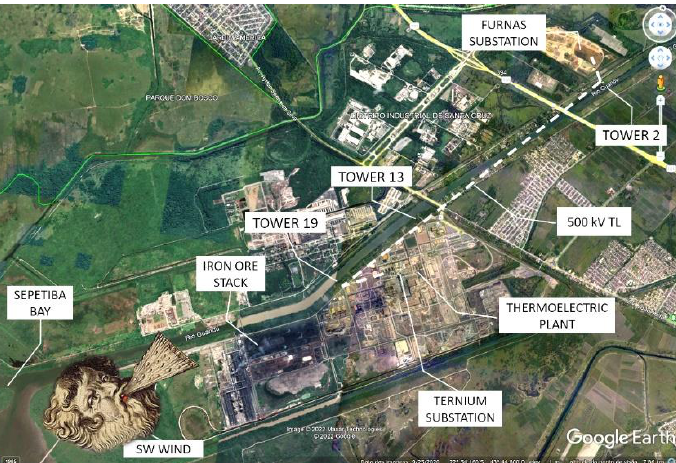
Figure 5. The transmission line and the three towers, with the sensors installed. The transmission line transports the energy generated by the Ternium Steel Co. thermoelectric plant to the Furnas National Grid Substation.